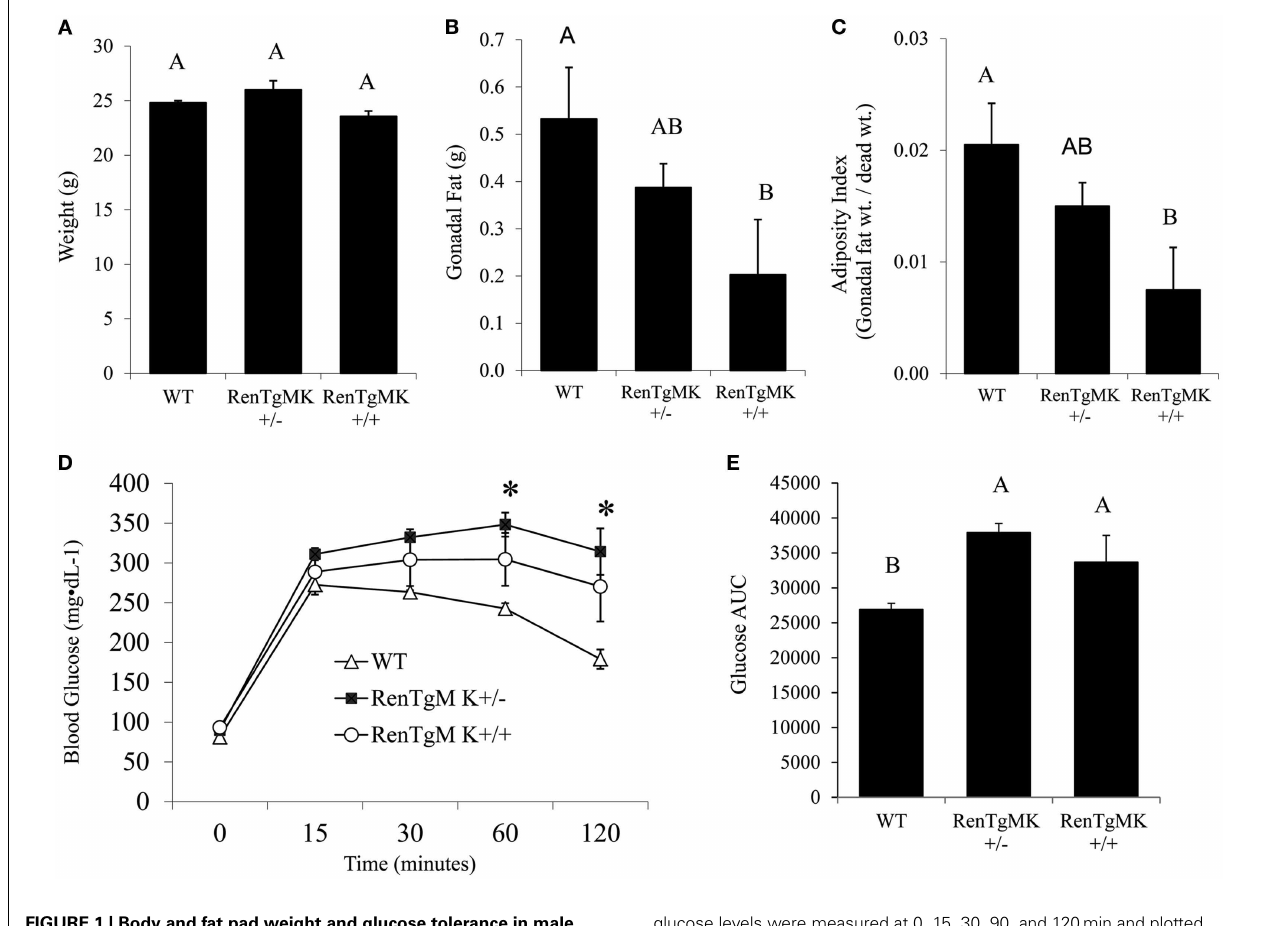
FIGURE 1 | Body and fat pad weight and glucose tolerance in male RenTgMK mice. (A) Body weight at the age of 20weeks. (B) Mice were sacrificed at the end of week 20 and gonadal fat pads were collected and weighed. (C) The adiposity index was determined by dividing gonadal fat pad weight by final body weight. A glucose tolerance test (GTT) was administered after overnight fasting. (D) Blood